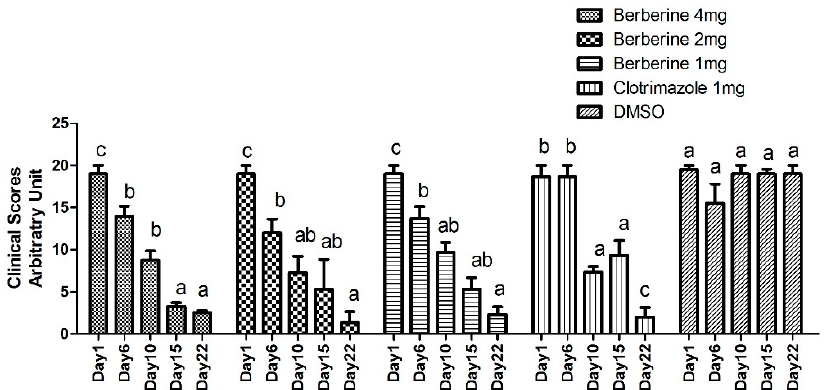
Figure 3. Different doses of berberine were applied to groups 1, 2, and 3 from Day 1, for 3 consecutive days. Clotrimazole or DMSO was applied topically in parallel. The animals were assessed for symptoms for 22 days, according to a previously described methodology In this evaluation, the infected area of skin from each rabbit was divided into four equal quadrants and each area was scored as follows: 0, normal; 1, slightly erythematous patches; 2, well-defined redness, swelling, with bristling hairs, bald patches, or scaly areas; 3, large areas of marked redness, scaling, exposed patches, or ulceration in places; 4, partial damage to the covering and loss of hair; and 5, extensive damage to the covering and complete loss of hair. The scores from various treatment groups were compared. The results were compared using a one-way ANOVA and Tukey's HSD test. A p value < 0.05 was considered statistically significant. a,b,c. stand for significant different from groups, p value < 0.05.